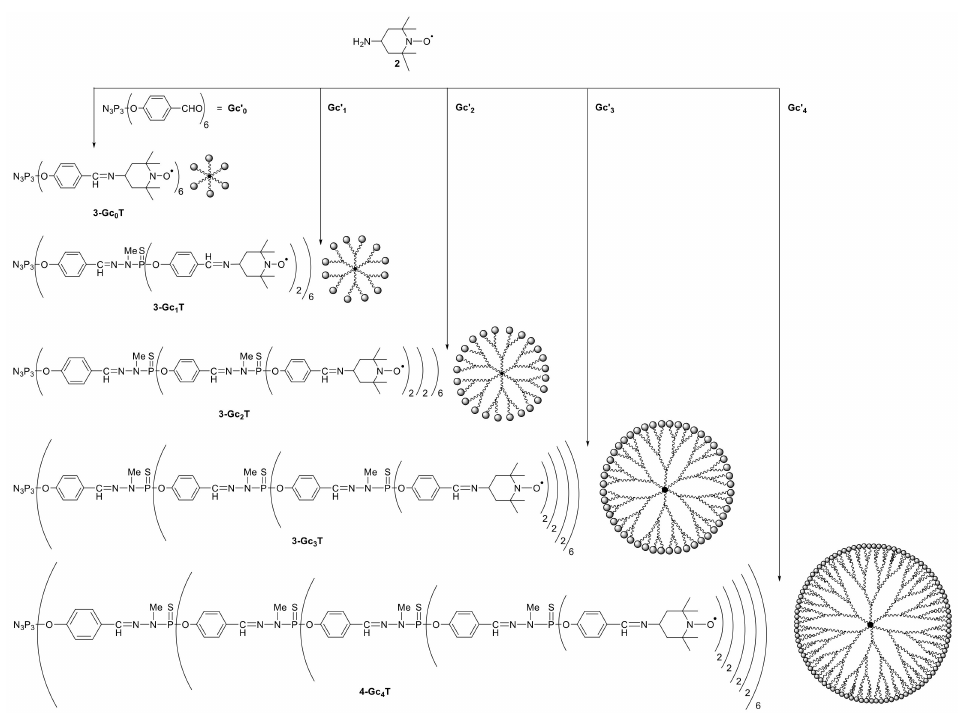
Scheme 1. Synthesis of five generations of PPH-based radical dendrimers (3-Gc 0 T, 3-Gc 1 T, 3-Gc 2 T, 3-Gc 3 T, and 3-Gc 4 T), with 6, 12, 24, 48, and 96 TEMPO radical units, respectively, at the periphery. Published by Macromolecules in 2014